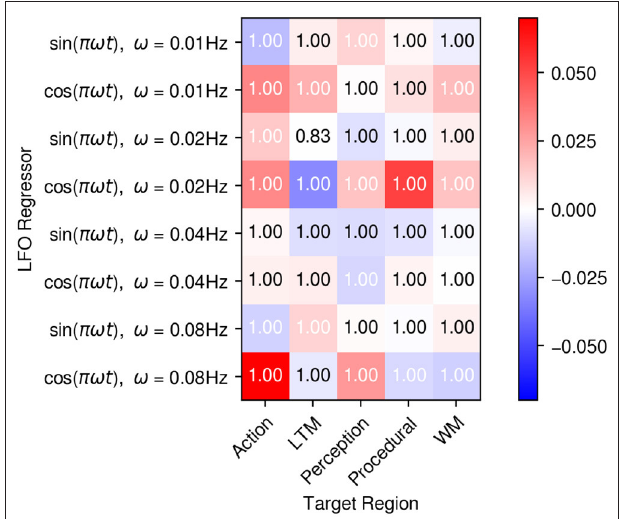
FIGURE 9 | Mean average weights of the LFO drives on each region. The matrix visually depicts the mean estimated value of the matrix C in Equation (1). Colors represent the mean values, while the numbers on each cell represent the expected probability that each weight w is different than zero, P ( | w | >